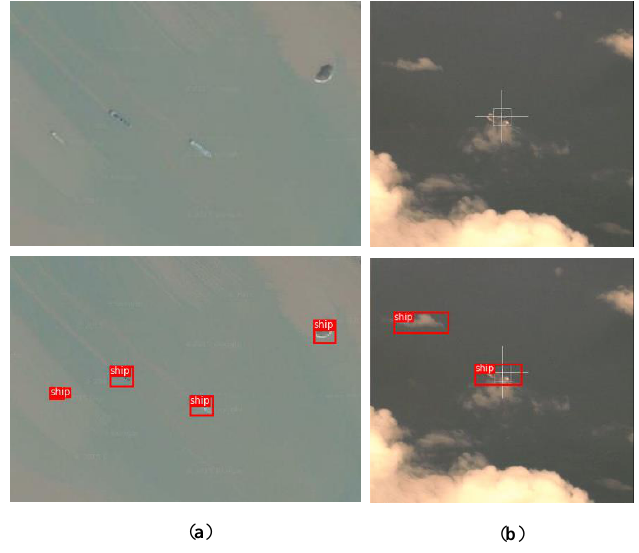
Figure 20. Examples of false alarms caused by different disturbances. ( a ) Islands; ( b ) Clouds.